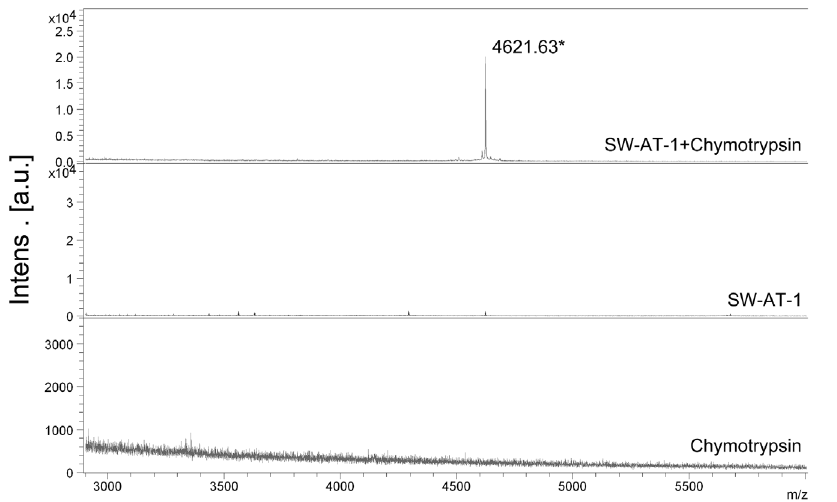
Figure 5. Cleavage site determination of SW-AT-1. Chymotrypsin, rSW-AT-1, and the reaction mixture of SW-AT-1 + chymotrypsin were directly analyzed by MALDI-TOF mass spectrometry. A representative strong single-accumulation spectrum is presented with the mass values on top of the MH + peaks at 4623.613 Da. The spectrum was subjected to noise removal and calibrated with an external standard of bovine serum albumin.